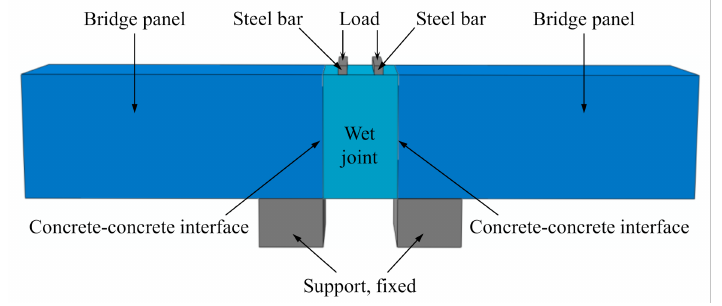
Figure 7. Finite element (FE) model of